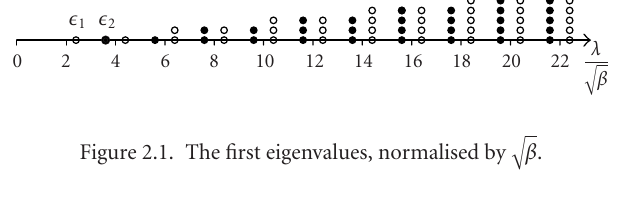
Figure 2.1. The first eigenvalues, normalised by